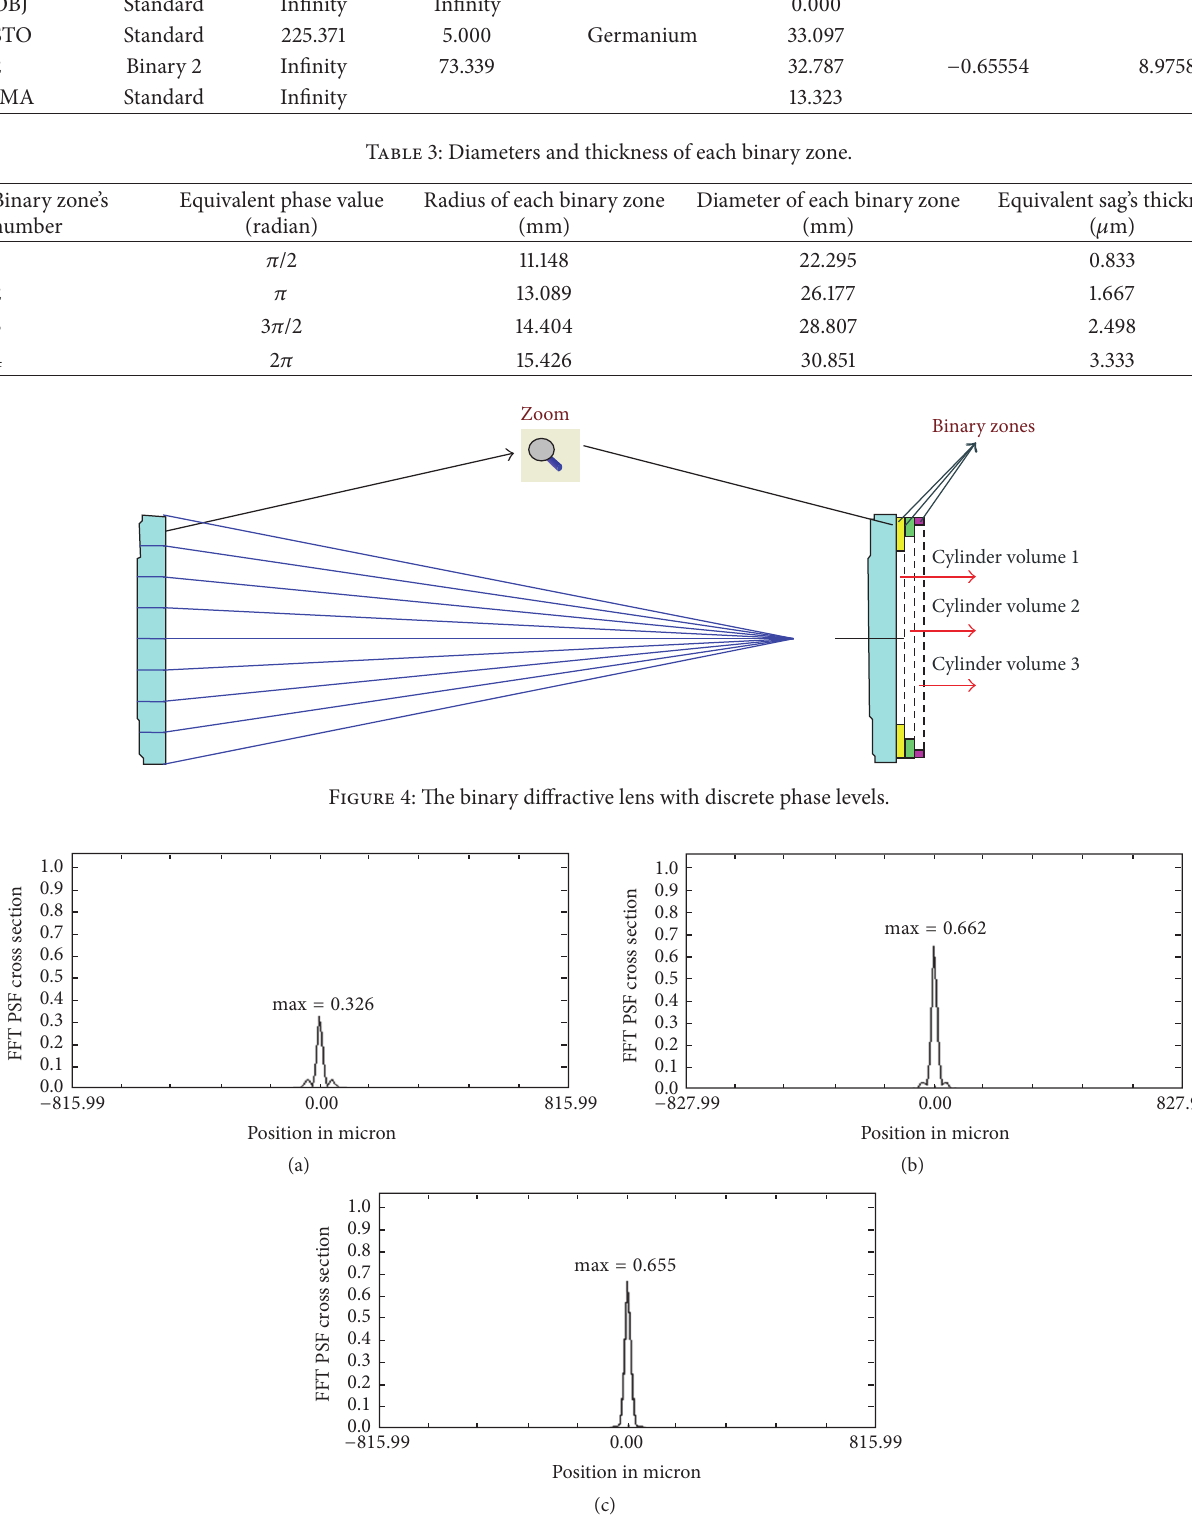
Figure 5: FFT PSF cross section of (a) refractive lens, (b) diffractive lens, and (c) designed binary